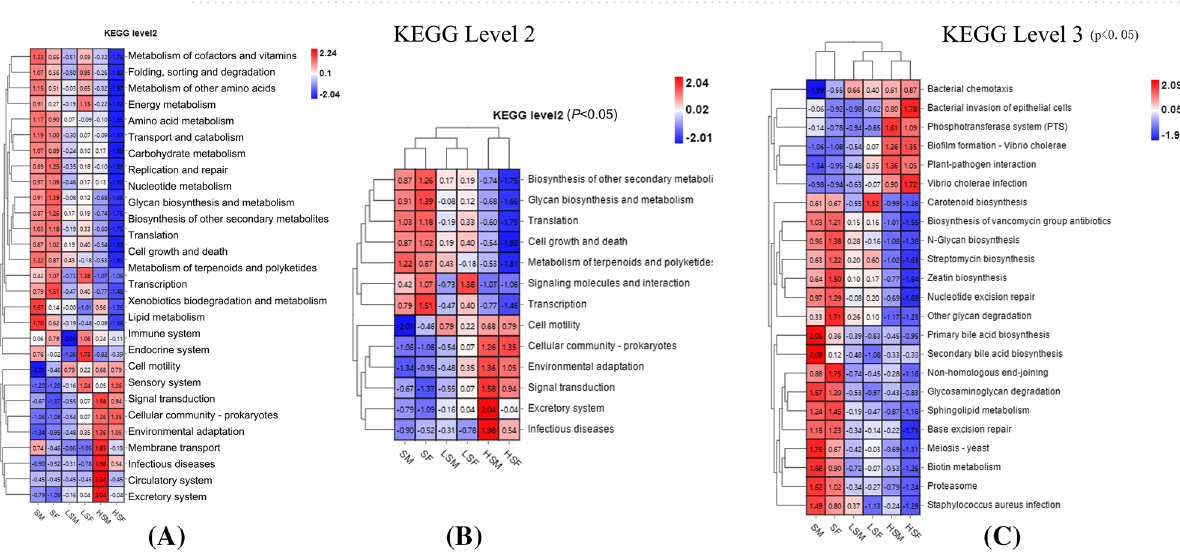
Figure 9. Heatmap of the abundance of genes with functional predictions within epiphytic bacterial communities on female and male S. thunbergii under increased UV-B radiation ( A ) Top 34 KEGG level 2 genes with functional predictions, ( B ) genes with significantly different functions ( P < 0.05) at KEGG level 2, ( C ) genes with extremely significantly different functions ( P < 0.01) at KEGG level 3, and some genes with significantly different functions ( P < 0.05), according to the KW rank sum test. For clarity, we use the term “HSM” to refer to “Male-high UV-B”, “LSM” to refer to “Male-low UV-B”, “SM” to refer to “Male-control", “HSF” to refer to "Female-high UV-B”, “LSF” to refer to “Female-low UV-B”, “SF” to refer to